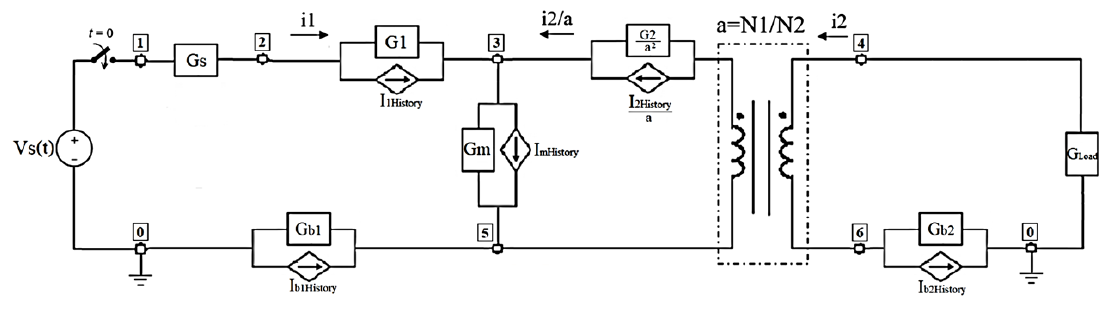
Figure 13. Secondary side branch of ideal transformer referred to the